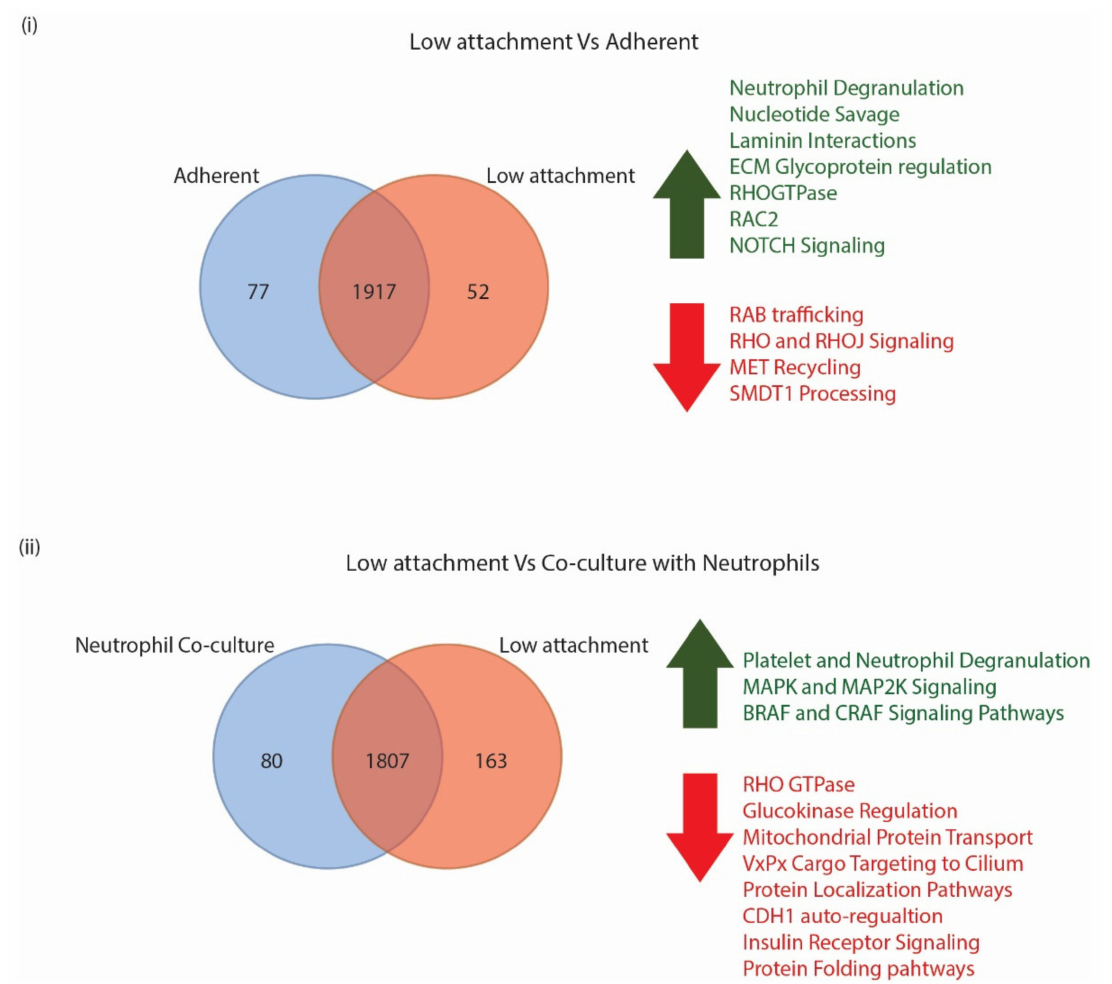
Figure 2. ( i ) Venn distribution of proteins identified in CM61 CTC cultured in adherent and non- adherent conditions along with cellular processes that are upregulated in green and downregulated in red. ( ii ) Venn distribution of proteins identified in CM61 CTC cultured in low attachment and in co-culture with naïve neutrophils along with cellular processes that are upregulated in green and downregulated in